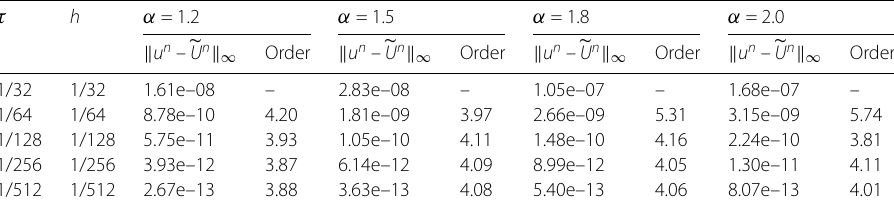
Table 1 L ∞ -norm errors and convergence orders of (cid:24) U obtained by the fourth-order scheme for Example